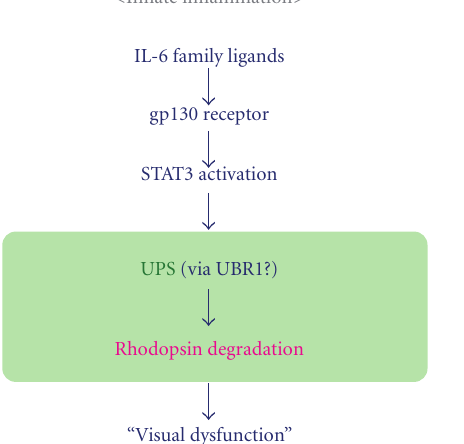
Figure 3: Model of the molecular mechanism in retinal inflammation. IL-6 family ligands induce STAT3 activation, which promotes exces- sive UPS-mediated rhodopsin protein degradation and subsequent visual dysfunction. Figure 4: Impairment of visual function and the protective e ff ect of ARB in diabetic mice. OPs in ERG from diabetic or nondiabetic mice. Amplitude and implicit time of OPs are impaired in the dia- betic mice, but these changes were avoided by administrating ARB (Telmisartan). ERG: electroretinogram; Ops: oscillatory potentials; ARB: Angiotensin II type 1 receptor